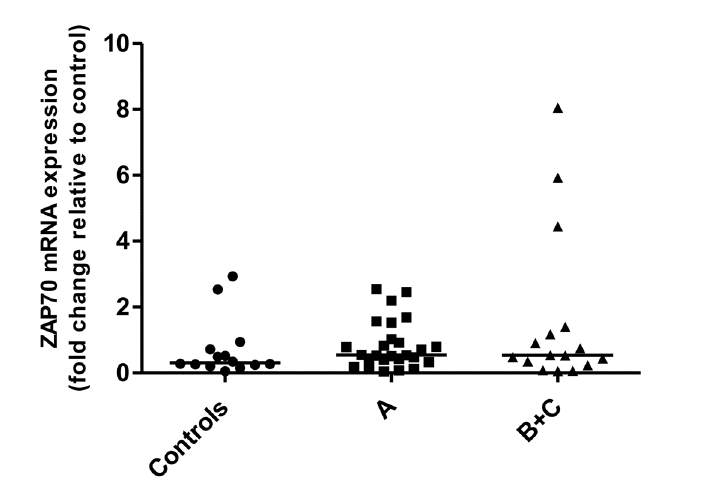
FIGURE 3 - ZAP-70 mRNA gene expression in the Controls, CLL Binet A (A) and Binet B+C (B+C). The transcript levels of ZAP-70 were similar among the studied groups. Data was presented as median values generated by ANOVA, followed by the Kruskal-Wallis